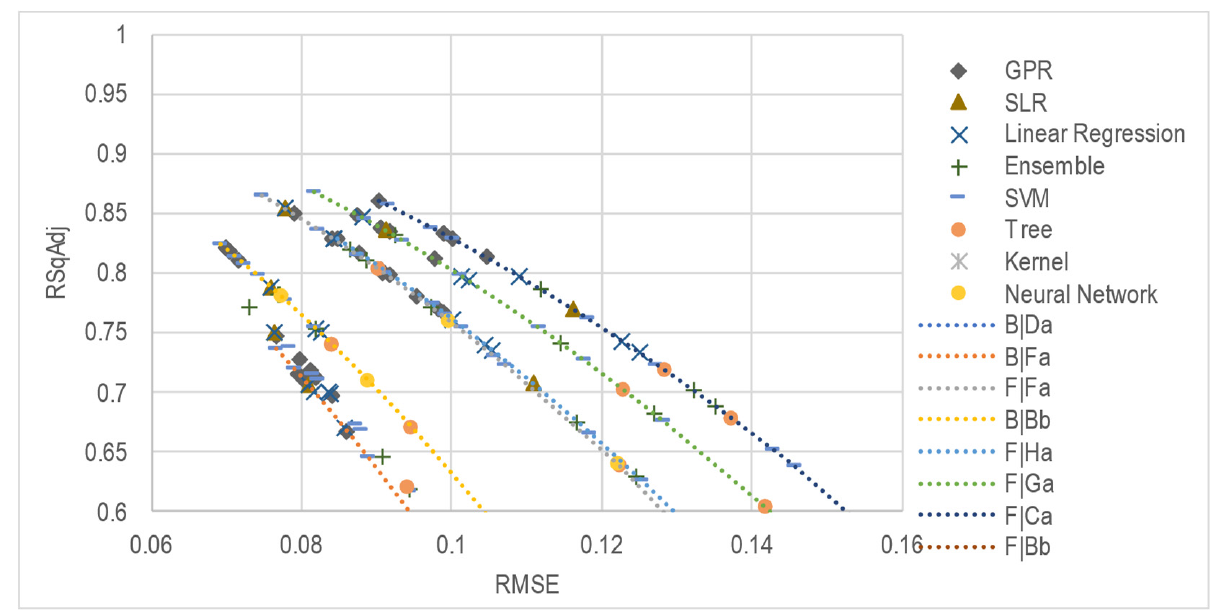
Figure 5. Nonparametric tested models with two predictors (age and hours) of combine families with best RMSE and RSqAdj results.